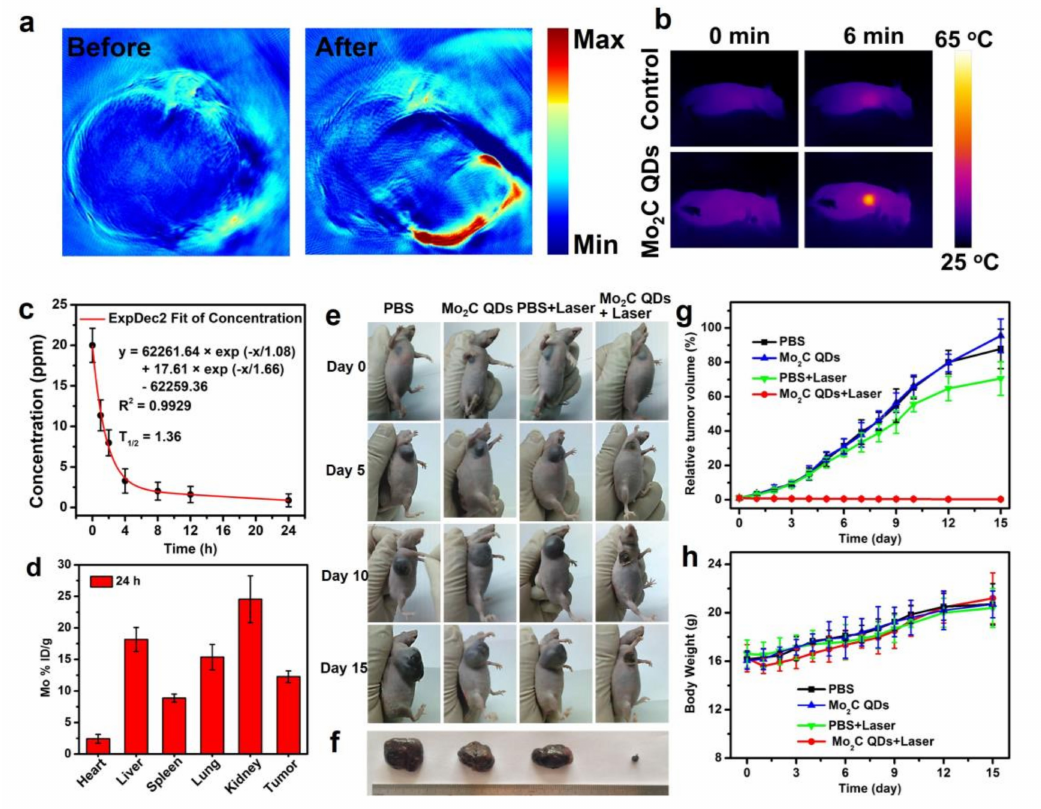
Figure 5. ( a ) In vivo PA images of a tumor-bearing mouse taken at before and after intravenous injection of Mo 2 C QDs; ( b ) IR thermal images at tumor site of a tumor-bearing mouse under an 808 nm laser irradiation (0.64 W/cm 2 ) ( c ) The blood circulation lifetime of Mo 2 C QDs after intravenous injection into nude mice ( n = 5); ( d ) The biodistribution of Mo in main tissues and tumor after intravenous injection for 24 h; ( e ) Photographs of tumor-bearing mice at different time points; ( f ) Photographs of tumors after the treatments; ( g ) The tumors growth curves and ( h ) body weight curves of tumor-bearing mice in different